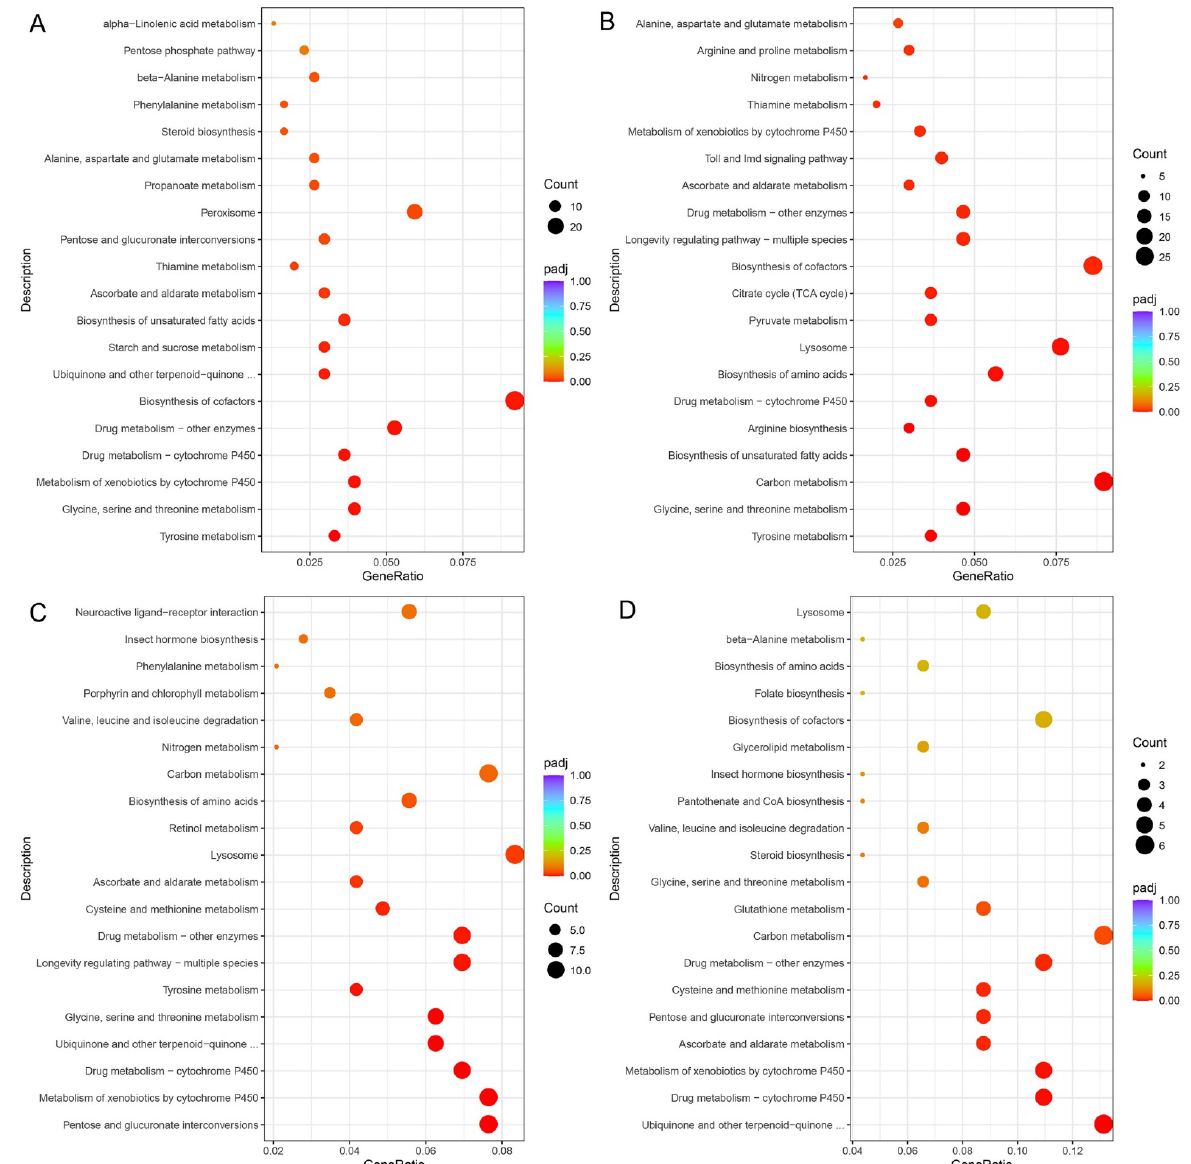
Figure 7. KEGG enrichment scatter plots of DEGs. ( A ). Up-regulated KEGG enrichment pathways of DEGs pairwise of AD vs. PL. ( B ). Up-regulated KEGG enrichment pathways of DEGs pairwise of PR vs. PL. ( C ). Down-regulated KEGG enrichment pathways of DEGs pairwise of PL vs. PS. ( D ). Down-regulated KEGG enrichment pathways of DEGs pairwise of PR vs.